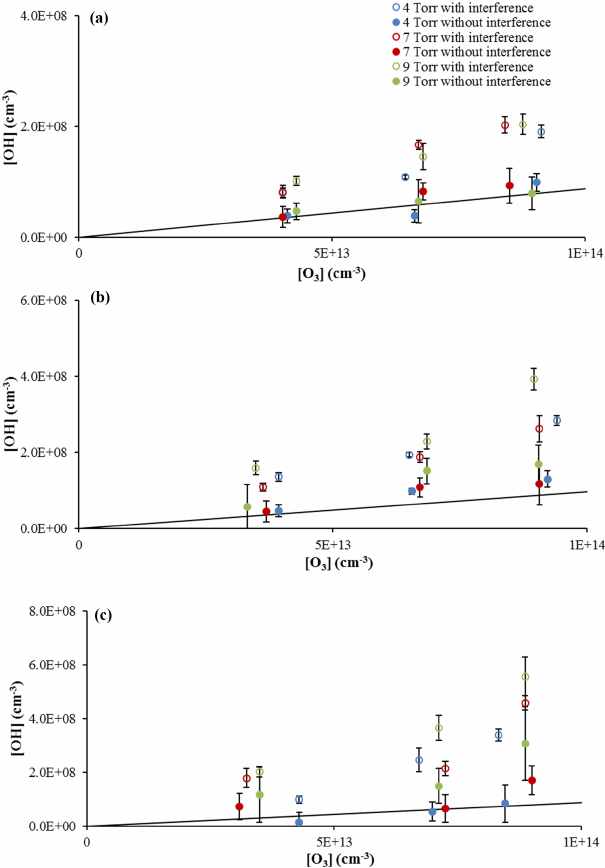
Figure 3. OH concentrations from α -pinene ozonolysis at three cell pressures with and without the interference using the 0.6mm diam- eter nozzle and the short (a) , medium (b) , and long (c) inlet lengths with α -pinene concentrations of approximately 3 × 10 12 cm − 3 . Er- ror bars indicate the precision of the measurement (1 σ) . Lines indi- cate the expected steady-state OH concentration based on published values of the OH yield (see